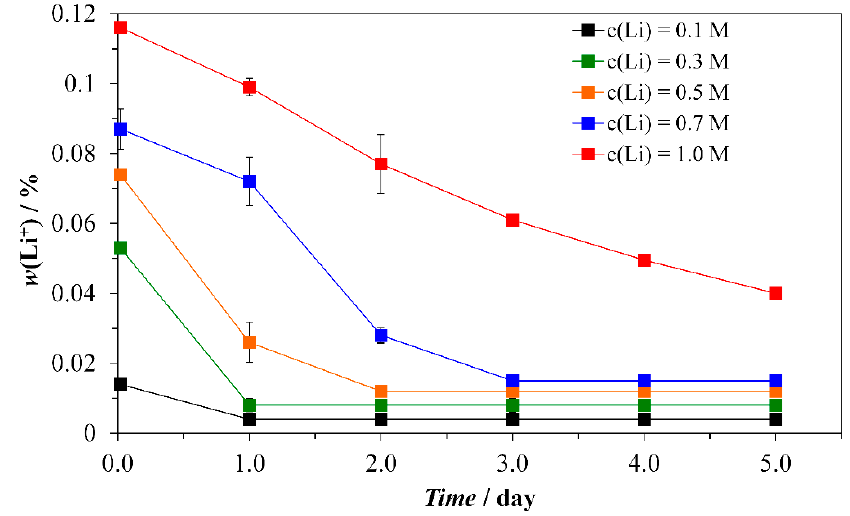
Figure 4. The content of Li + incorporated into the crystals during the transformation process in the precipitation systems, c i (CaCl 2 ) = c i (NaHCO 3 ) = 0.1 mol dm − 3 , with different initial concentration of Li + . The initial concentrations of Li + in solution are indicated: M correspond to mol dm − 3 .